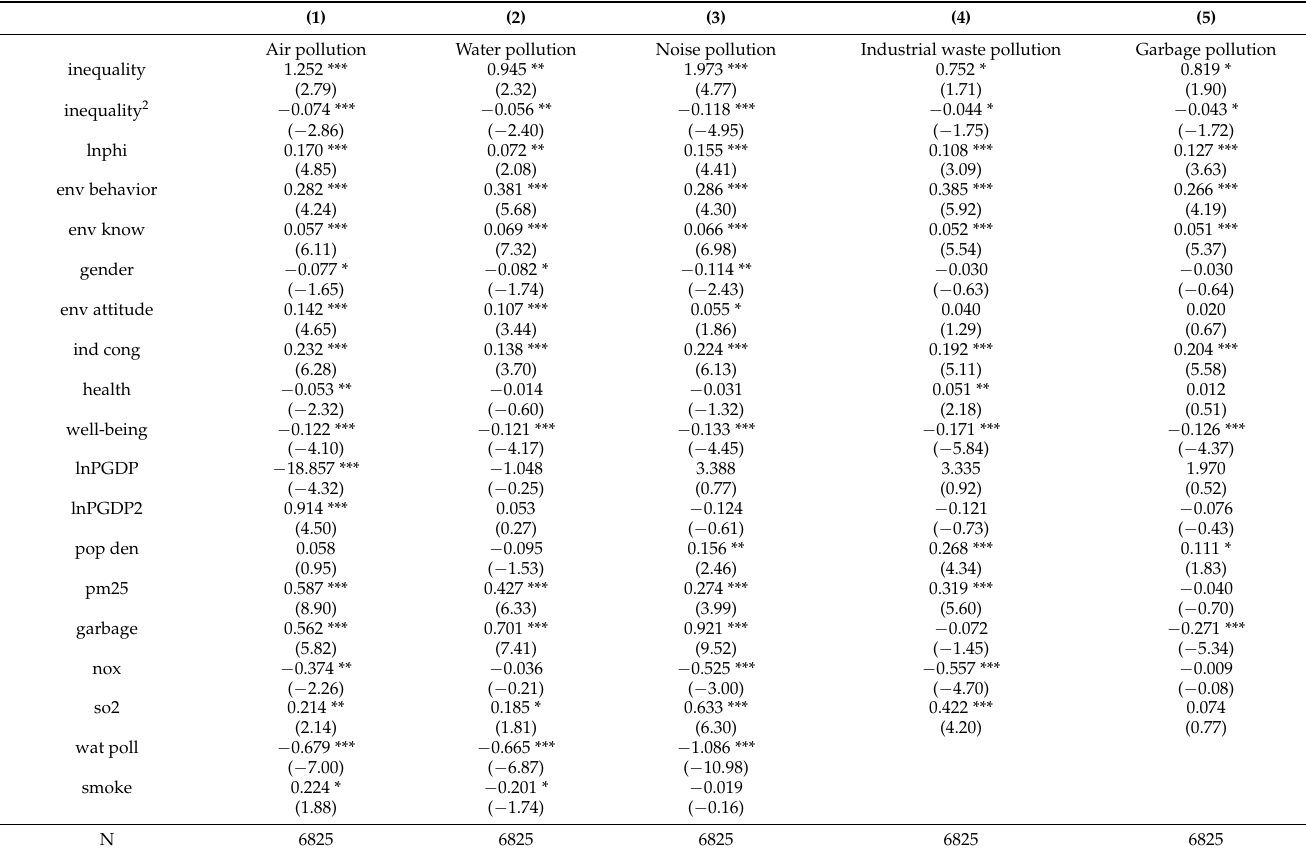
Table A6. The effect of individual-level income inequality on different subjective environmental